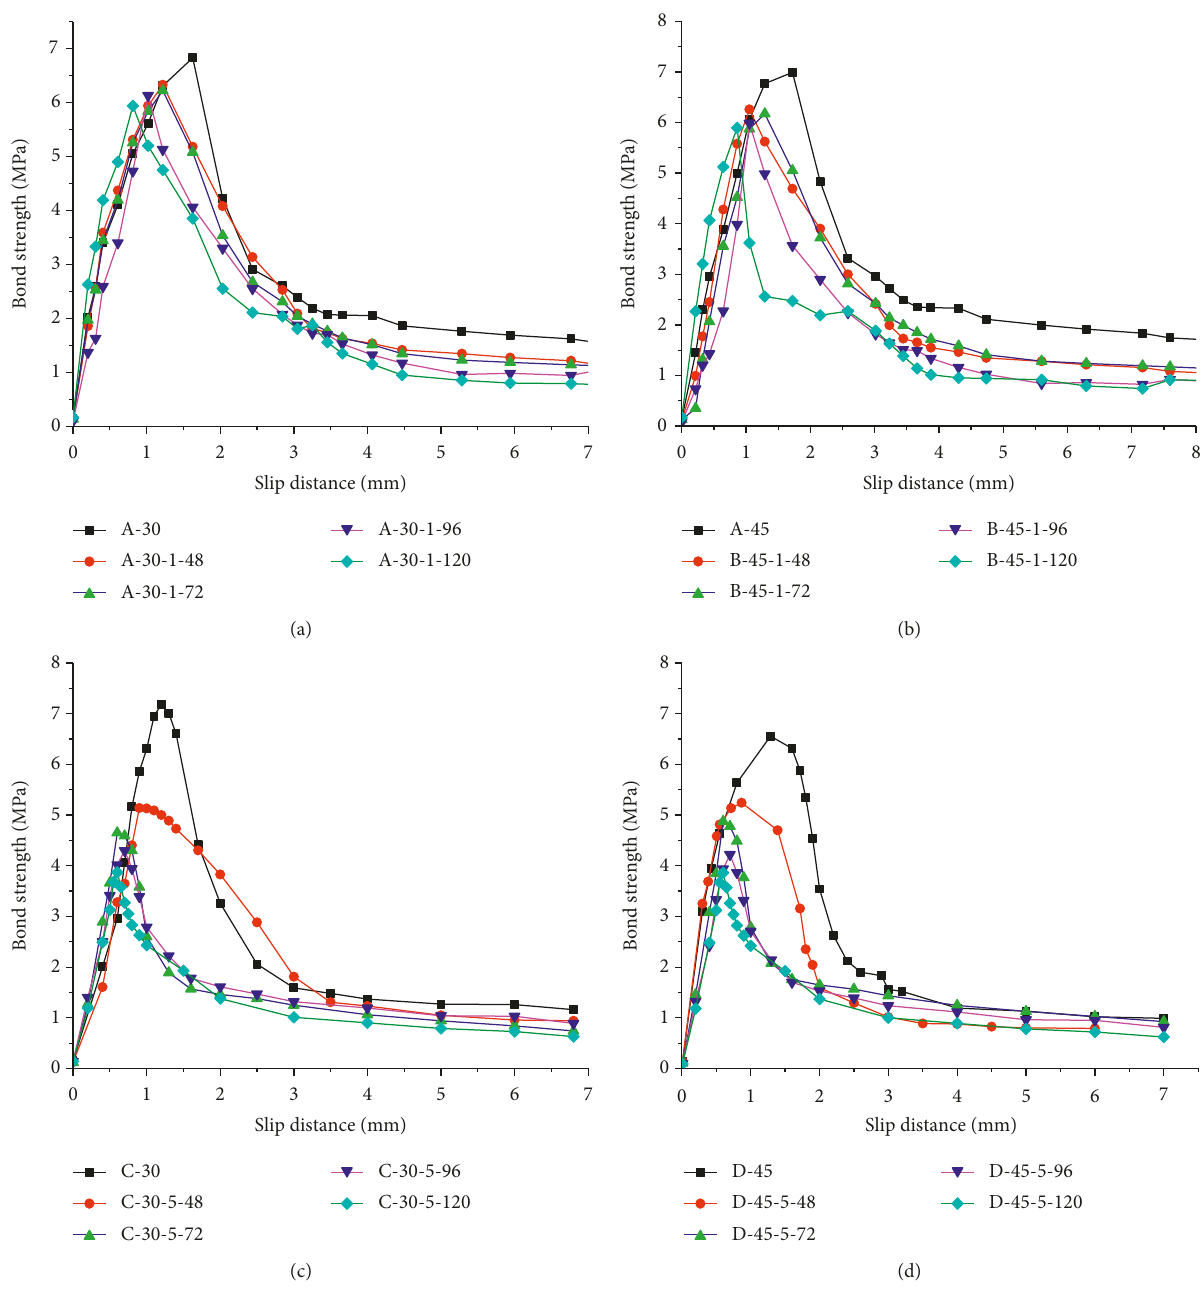
Figure 12: Bond strength-slip distance